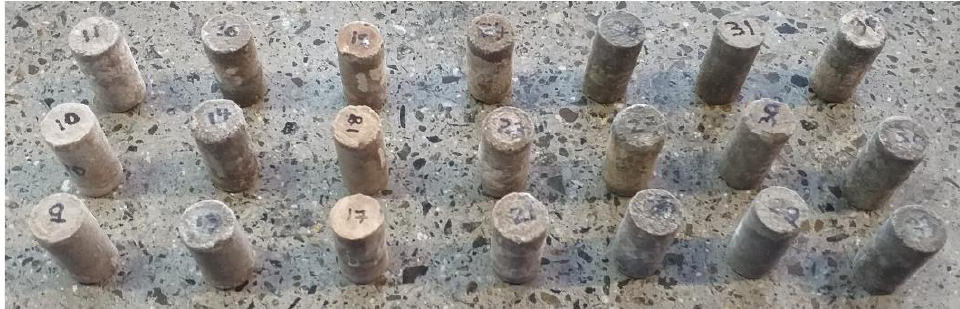
Figure 2. Alkali-activated stone wool fiber specimens with and without OPC